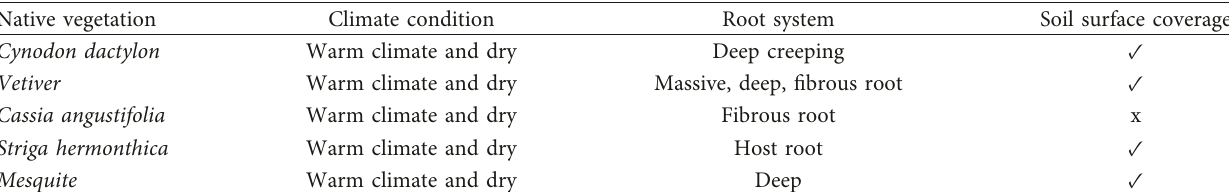
Table 10: Native plant identification